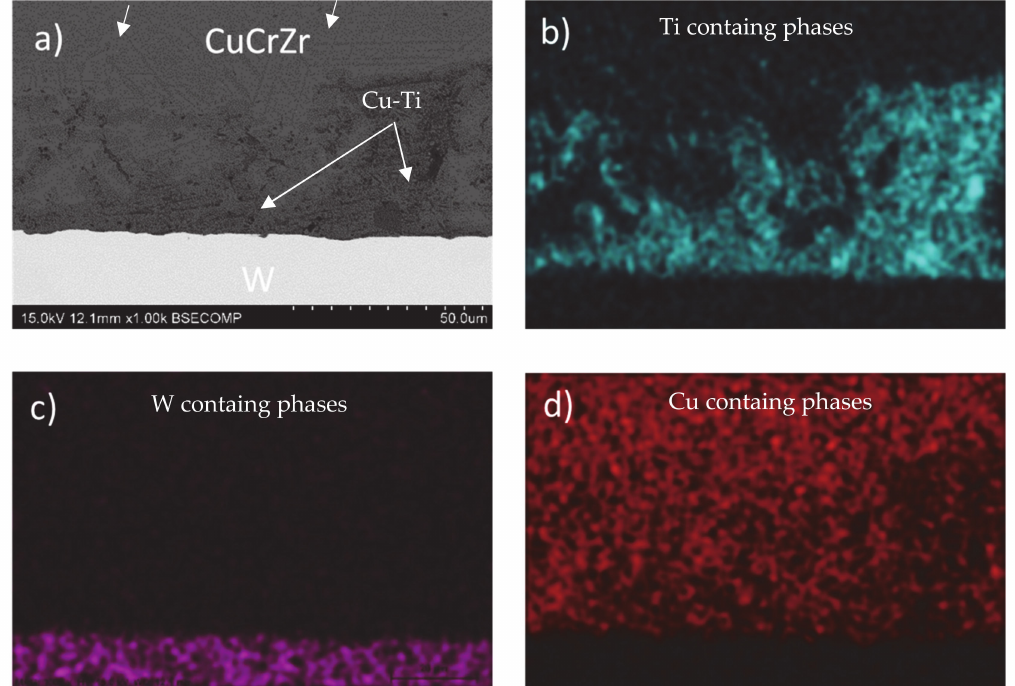
Figure 3. ( a ) SEM micrograph of the W-CuCrZr brazed joint, ( b – d ) elemental distribution of Ti, W, and Cu in the joint,